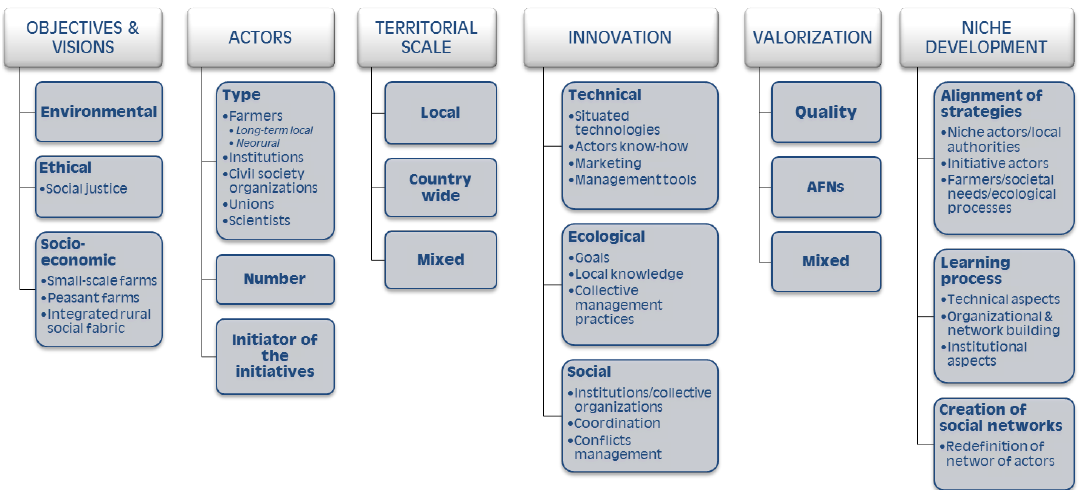
Figure 1. Themes and relative dimensions identified for the construction of the meta-database.